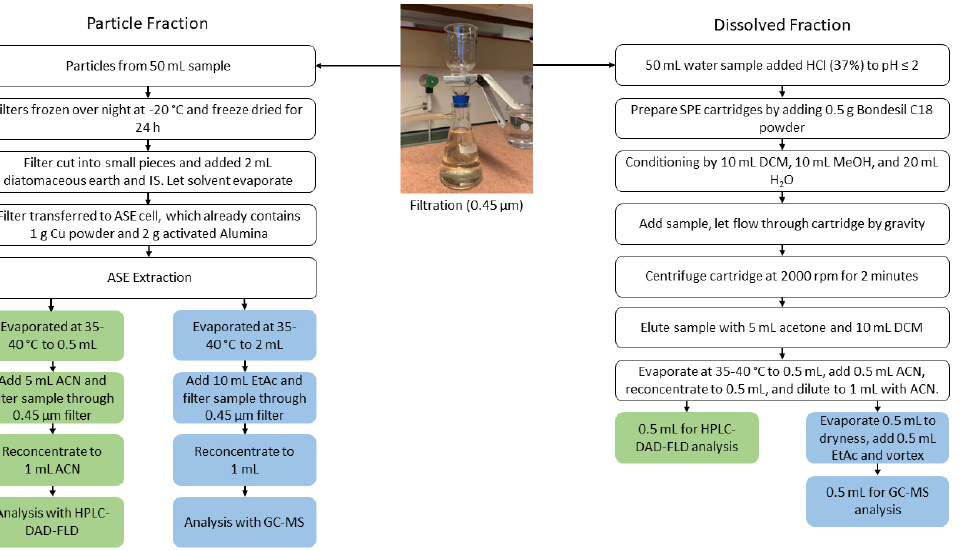
Figure 3. Schematic of the extraction procedure for particulate-bound PAH target analytes ( left side ) and the dissolved PAH target analytes ( right side ). The method for extraction of the dissolved phase PAHs was adapted from the EPA Method 8310 [16,17].